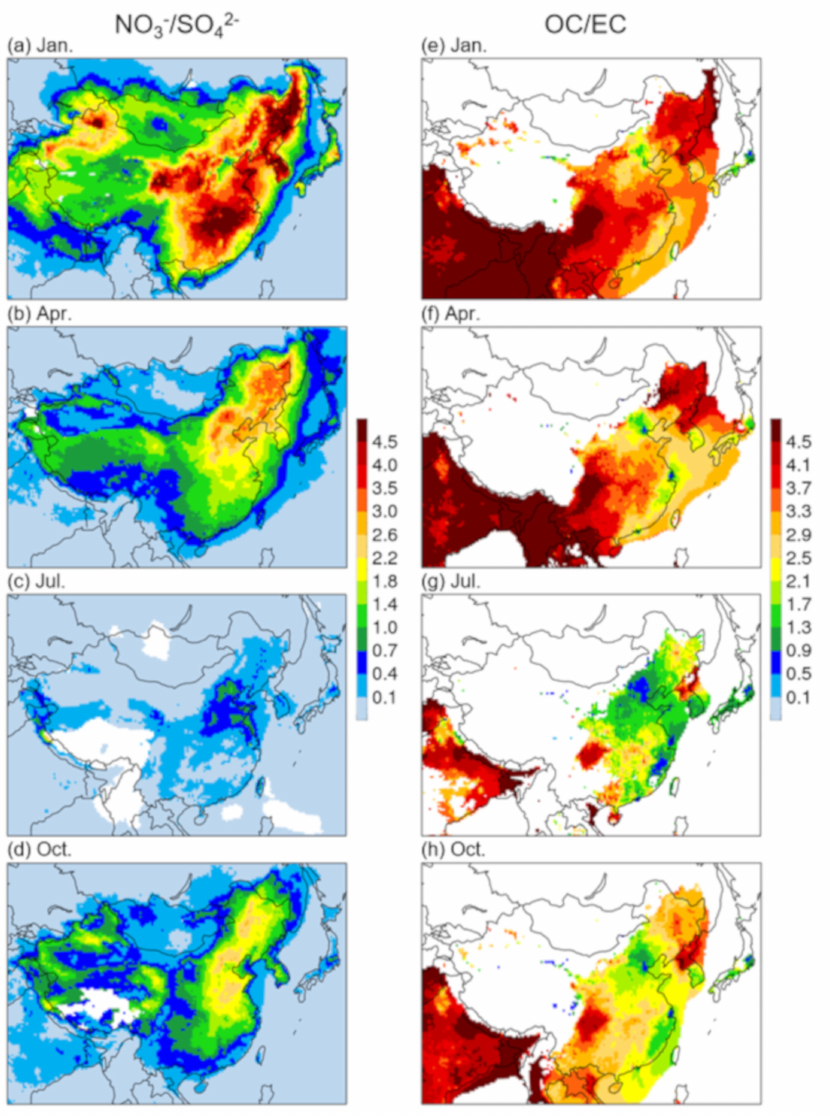
Figure 8. Spatial distributions of simulated monthly mean NO 3 − /SO 42 − and OC/EC ratios for January ( a , e ), April ( b , f ), July ( c , g ), and October ( d , h ) in